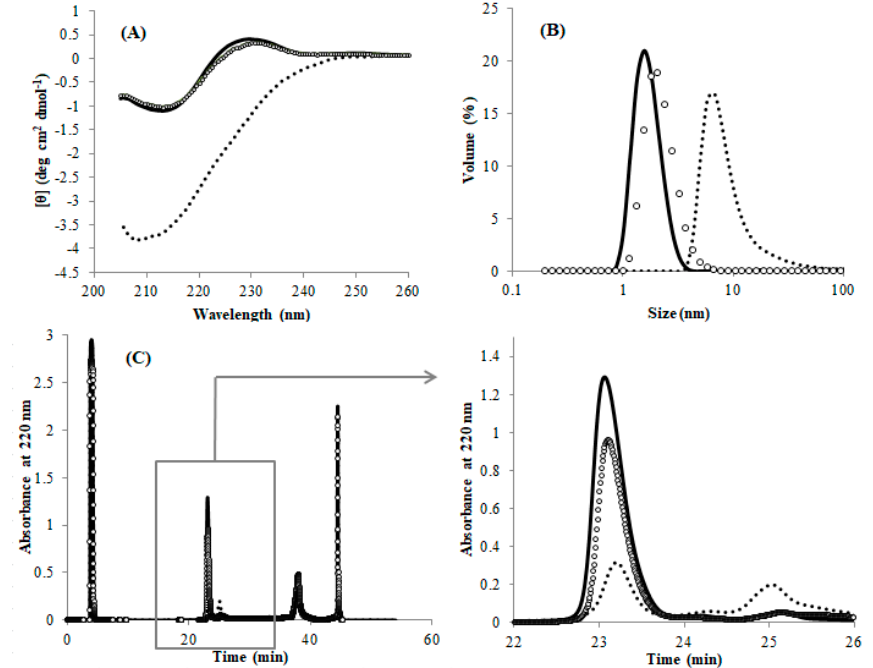
Figure 4. Physical properties of DEN4 ED3-1st sup (solid line); DEN4 ED3-3rd ppt (dotted line); DEN4 ED3-3rd ppt after the incubation with 100 mM DTT (white circle) at a protein concentration of 20 µM. (A) CD spectra at pH 5 and 20°C. (B) Size-volume graphs measured by DLS at pH 8 and 20°C. (C) RP-HPLC chromatograms at pH 8, 30°C and a flow rate of 1 mL/min.